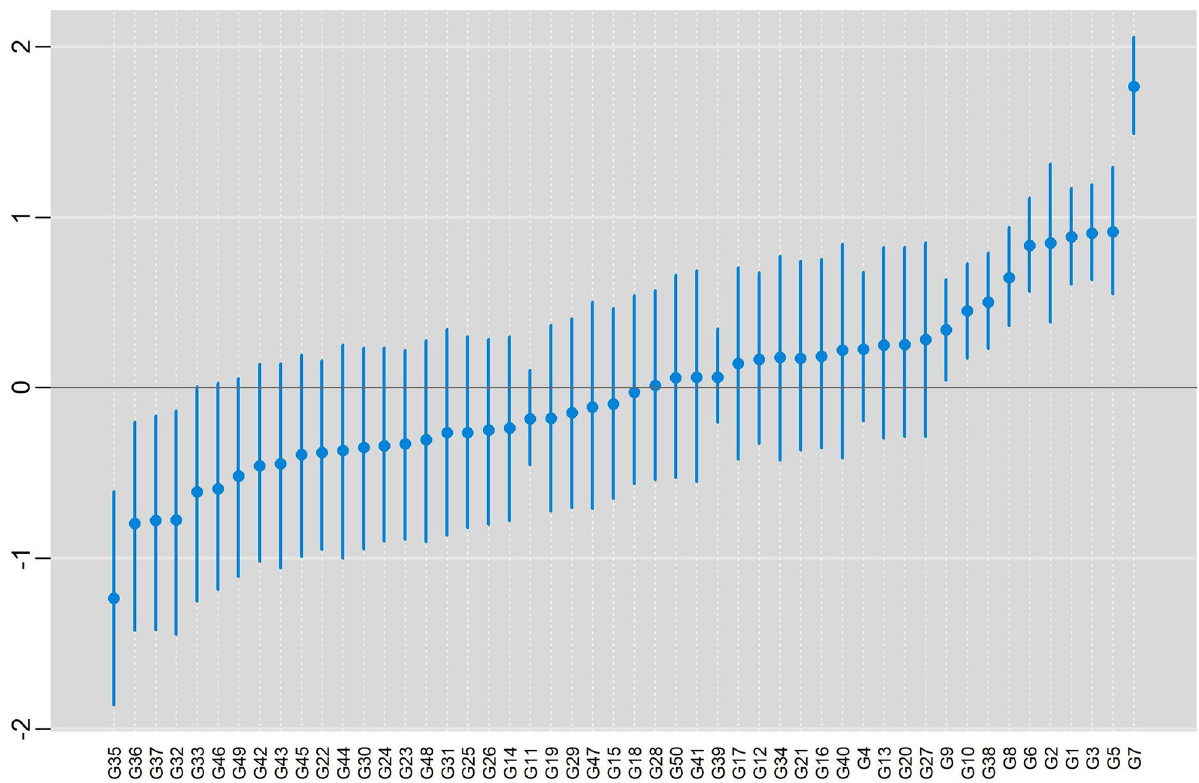
Fig 18. Posterior means and the 95% HPD intervals for the effect of genotypes, considering the BAMMI-4 model, for real data using the MCMC method.